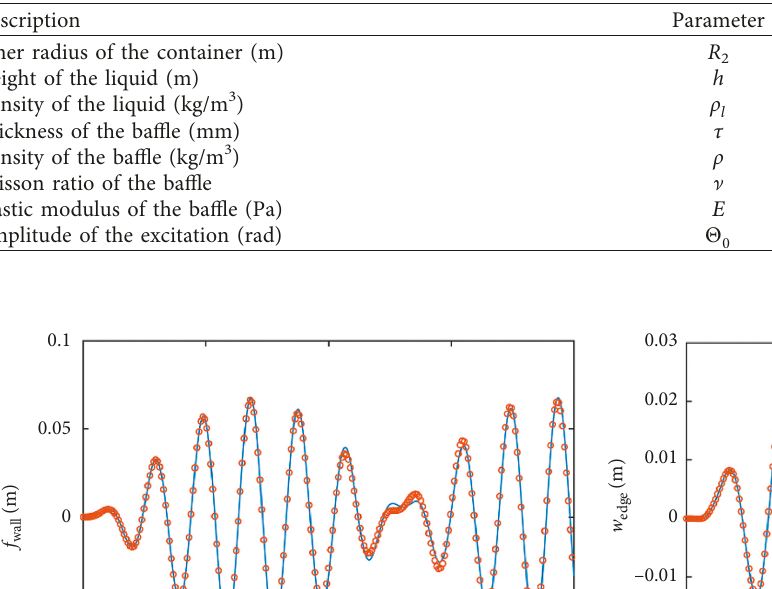
Table 1: Parameters for the liquid and the baffled container in the comparison analysis.